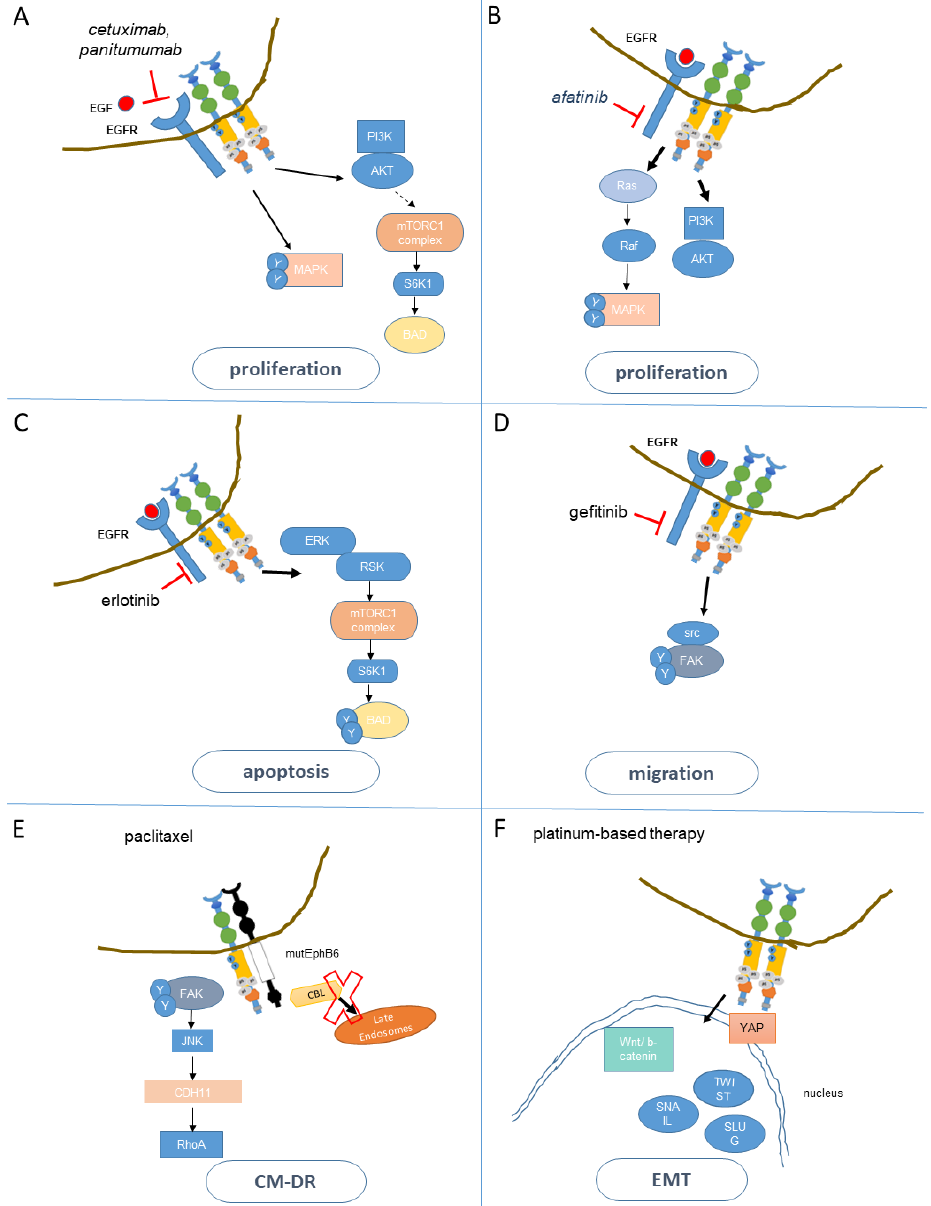
Figure 3. Main mechanism(s) of EphA2 mediated resistance to therapy. ( A ). EphA2-mediated activation of PI3K /AKT and MAPK mediated resistance to the EGFR blocking antibody cetuximab (and, possibly, panitumumab). ( B – D ) EphA2-driven activation of RSK/MTORC1/S6K1/BAD and FAK signaling mediated the resistance to anti-EGFR TKI. ( E ). Paclitaxel activated the Cell Adhesion Mediated-Drug Resistance (CM-DR) (mediated by mutEphB6-EphA2 interaction), through JNK/CDH11/RhoA/FAK signaling. ( F ) . Platinum-based therapies activated EphA2-mediated EMT driven by wnt-mediated activation of Snail, Slug, and Twist. Physical and functional interaction of EphA2 and YAP has been shown to mediate platinum resistance as well. Please note that while representing independent findings, it is likely that, especially for the anti-EGFR agents ( A – D ), the described mechanisms may coexist, given the similarity of action between these TKIs. Please also note that for the sake of clarity, in this scheme the tumor-tissue specificity has not been considered. The description of paclitaxel- and cisplatin-EphA2 driven response has been introduced here since those therapies can be used with EGFR TKI or anti-EGFR mabs in combination settings or further lines of treatment. Thin arrows indicate direct signaling, bold arrows indicate a more complex and rather indirect involvement in the indicated biological process.